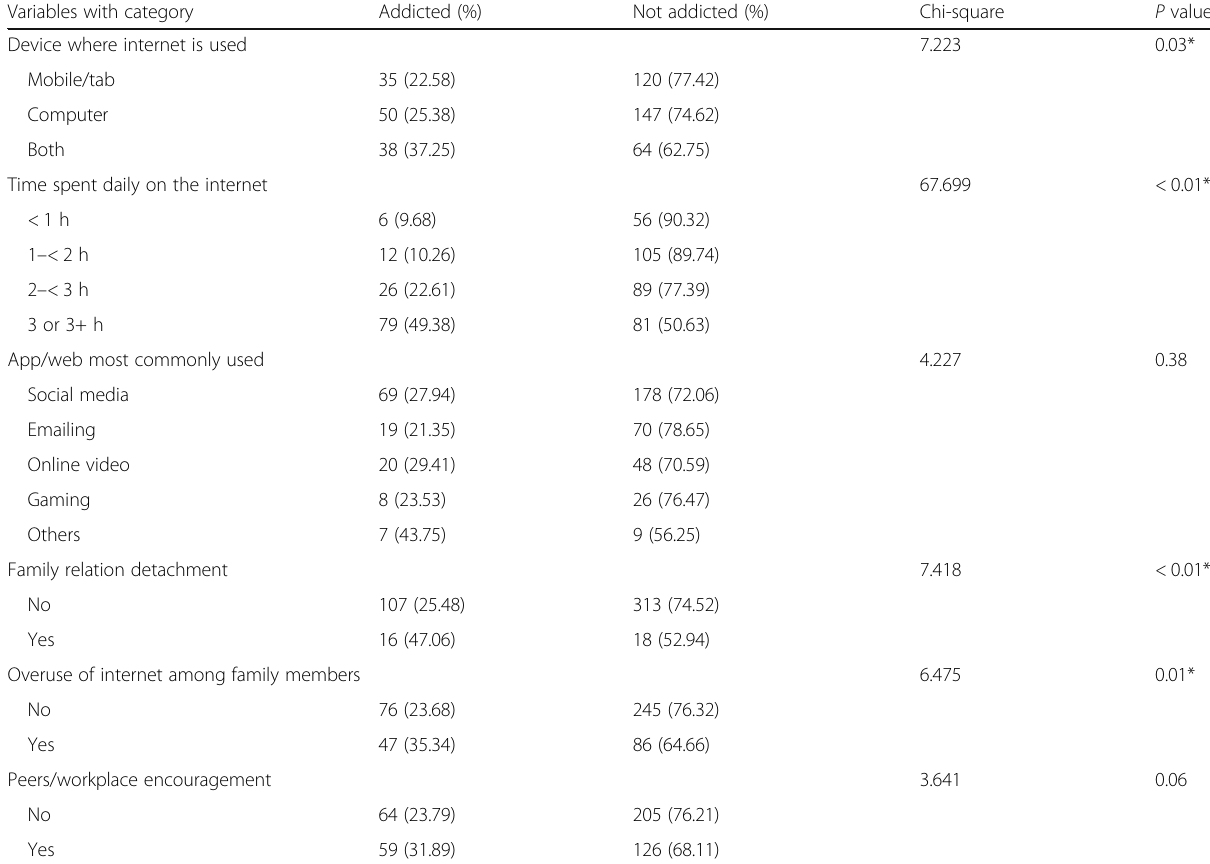
Table 3 Association of socio-demographic and activity related characteristics of internet users with internet addiction (Continued) Variables with